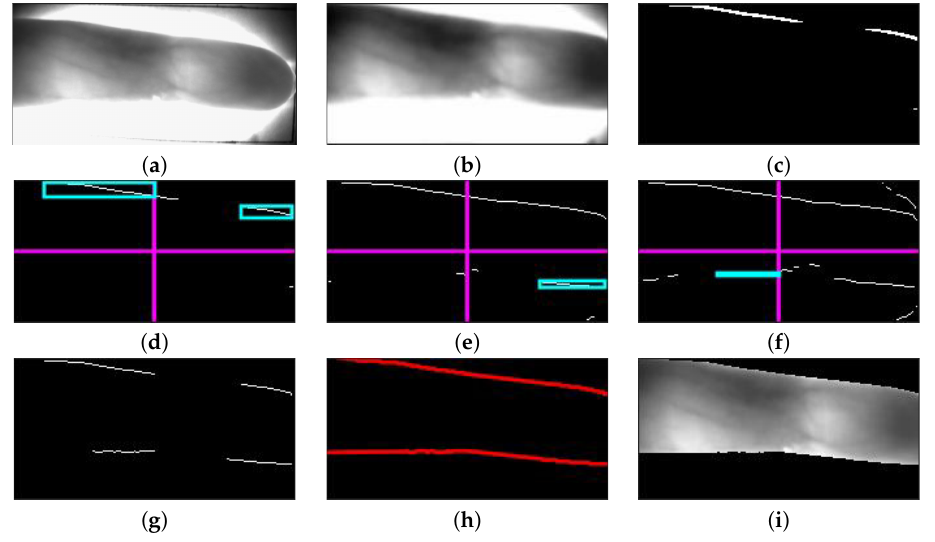
Figure 1. Proposed ROI localization scheme for an example: ( a ) original captured finger-vein image, ( b ) candidate image after filtering and cropping, ( c ) initial binary edge image by threshold of µ + 2 σ , ( d ) edge of the good quality part by µ + 2 σ (upper), ( e ) edge of the medium quality part by µ + σ (lower right), ( f ) edge of the poor quality part by µ + 0.5 σ (lower left), ( g ) final binary edge image, ( h ) binary edge image by interpolation and connection, and ( i )